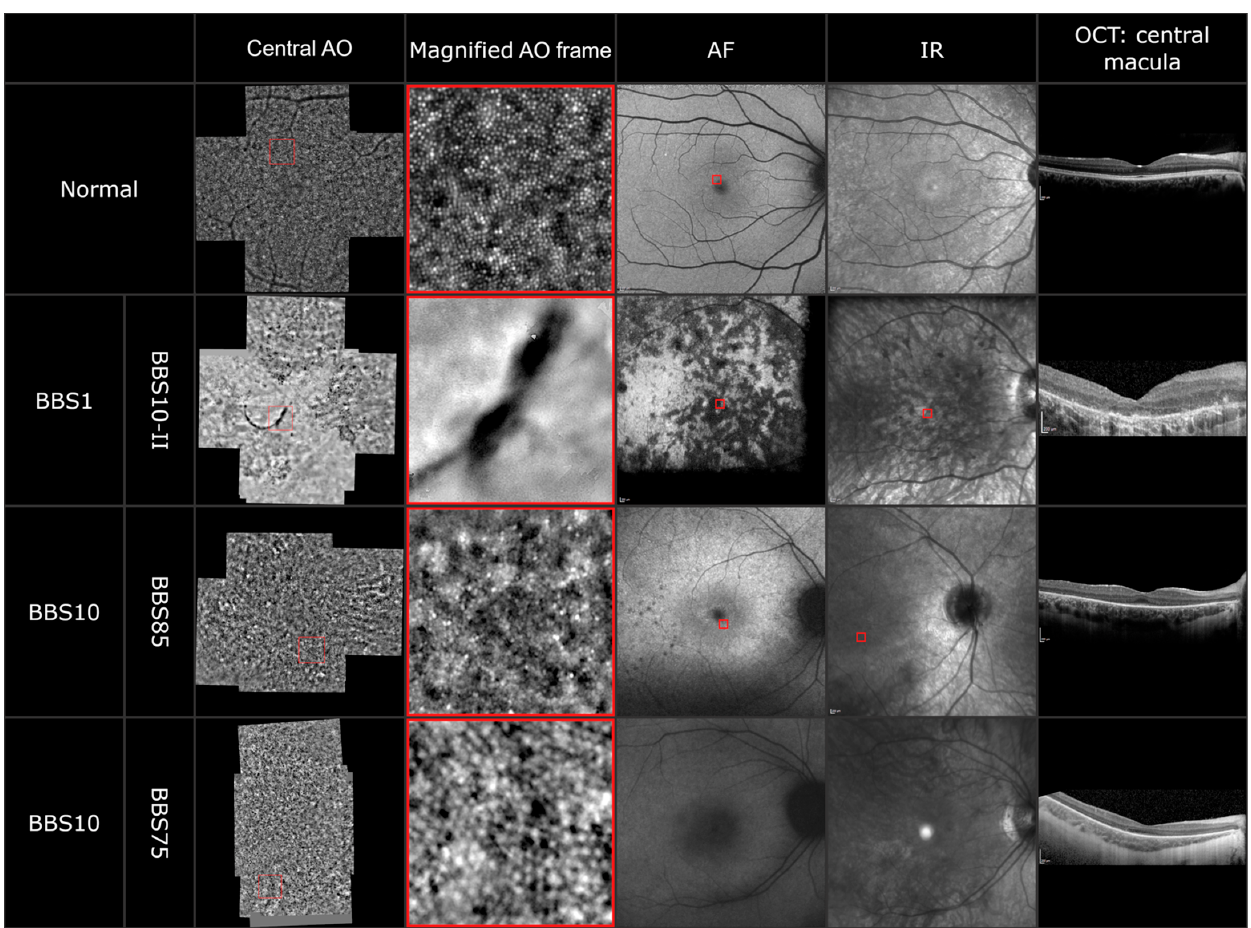
Figure 4. AO montage, magnified AO imaging (highlighted by a red frame), AF, IR and OCT of a healthy subject and three BBS patients carrying disease-causing variants in the BBS1 and BBS10 g enes.